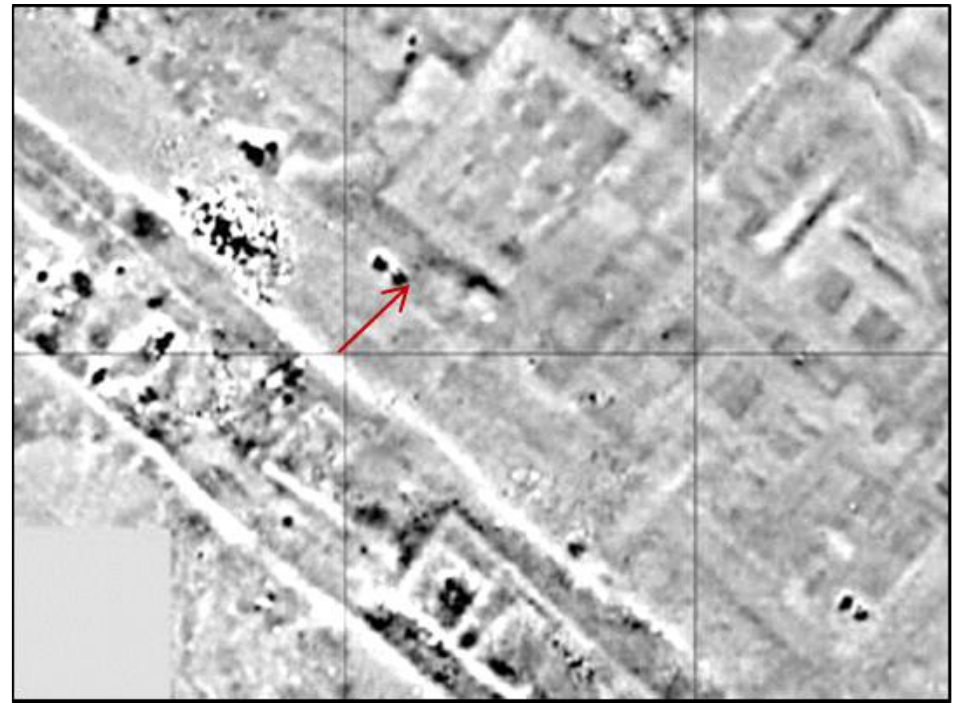
Figure 10. Casemate structure at Tell el-Balamun detected using magnetic survey [59]. The remotely sensed structure (Installations G) at Hermopolis, shown in Figure 9, resembles the Tell el-Balamun structure.